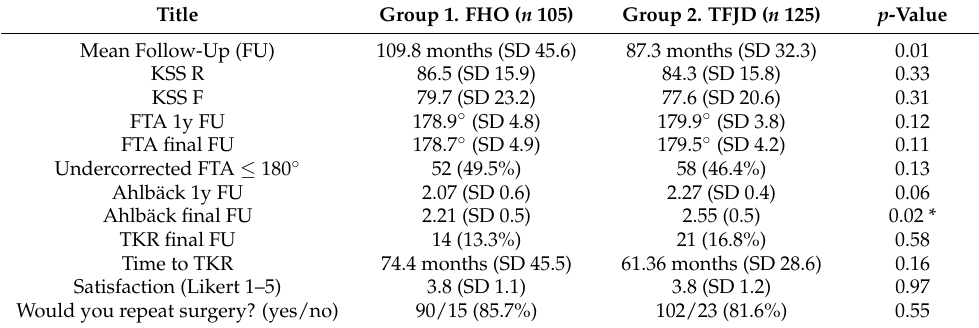
radiological 1 year follow-up (FTA 1y FU and Ahlbäck 1y FU), radiological final follow-up (FTA